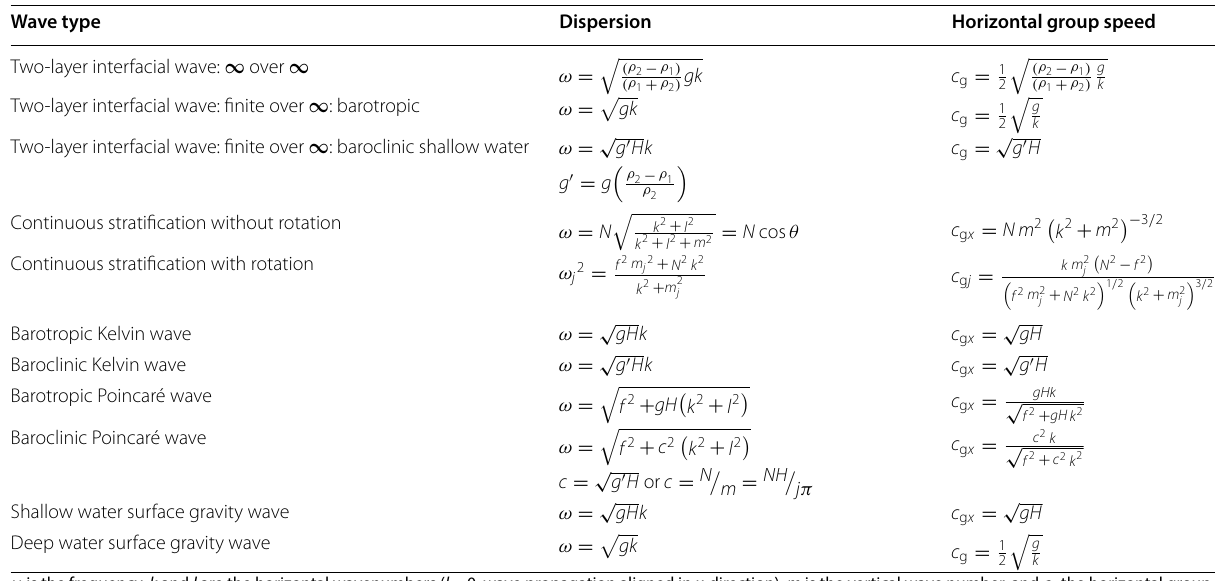
ω is the frequency, k and l are the horizontal wavenumbers ( l 0, wave propagation aligned in x -direction), m is the vertical wave number, and c g the horizontal group = speed. The water depth is H and the upper layer thickness is H U . Gravity is g and the reduced gravity is g ʹ . ρ 1 and ρ 2 are the densities of the upper and lower layers, respectively. N is the Brunt – Väisäla frequency and f is the inertial frequency for the latitude. The mode number is represented by j . The equations were taken from Kundu et al.